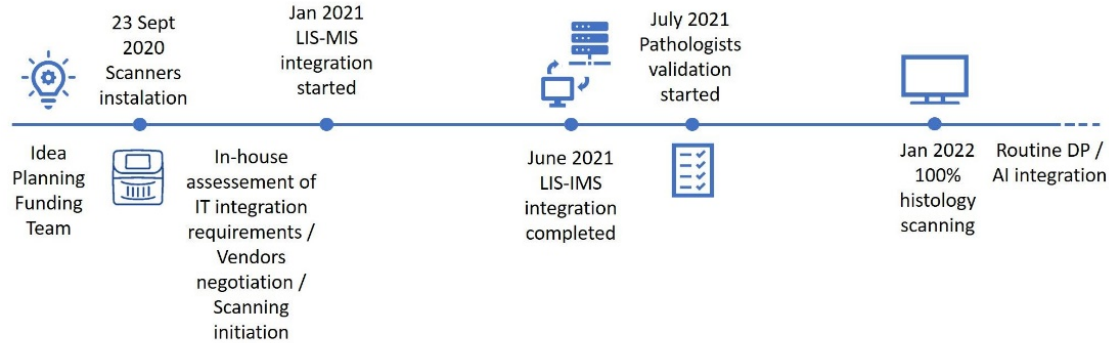
Figure 1. Digital implementation track timeline. DP, Digital Pathology; IMS, Image Managing System; LIS, Laboratory Information System.